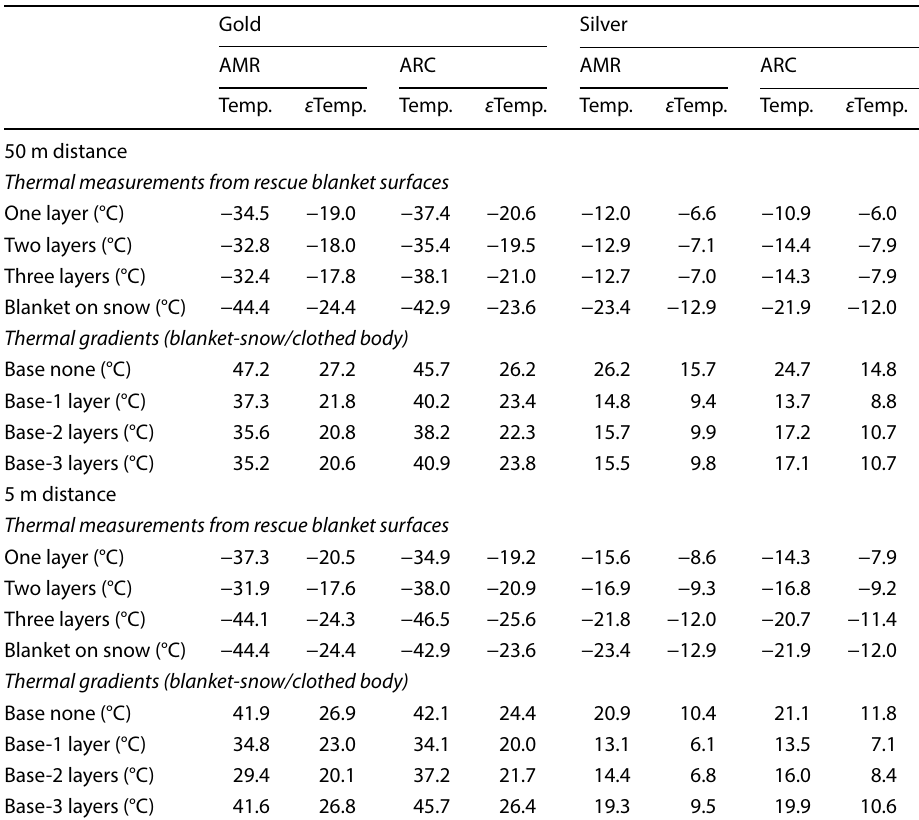
Table 2 Thermo-radiation measurements from one, two and three layers of two different rescue blankets (AMR: Austrian Mountain Rescue, ARC: Austrian Red Cross) covering a clothed body dressed in a fleece, plus down jacket, plus all-weather jacket (base) as compared to infrared measurements of a single- layer rescue blanket on snow made with a thermal camera at distances of 50 m